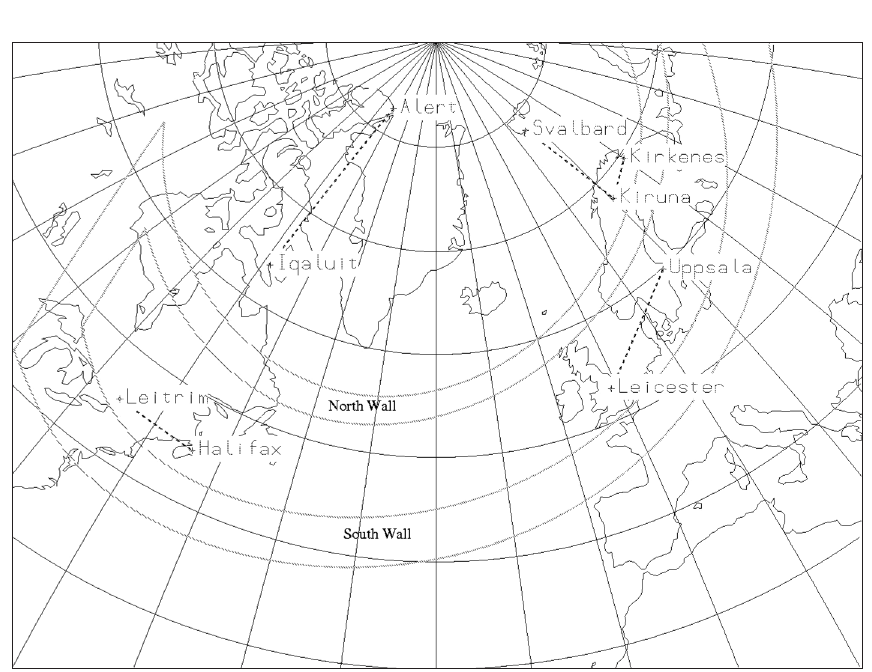
Fig. 14.1. Map showing the propagation paths discussed in this paper. Also shown is the position of the trough as estimated by the model of Halcrow and Nisbet (1977) for 00:00 UT on 11th March 2001, Kp = 3. The four lines indicate the outer and inner edges of the north and south walls.